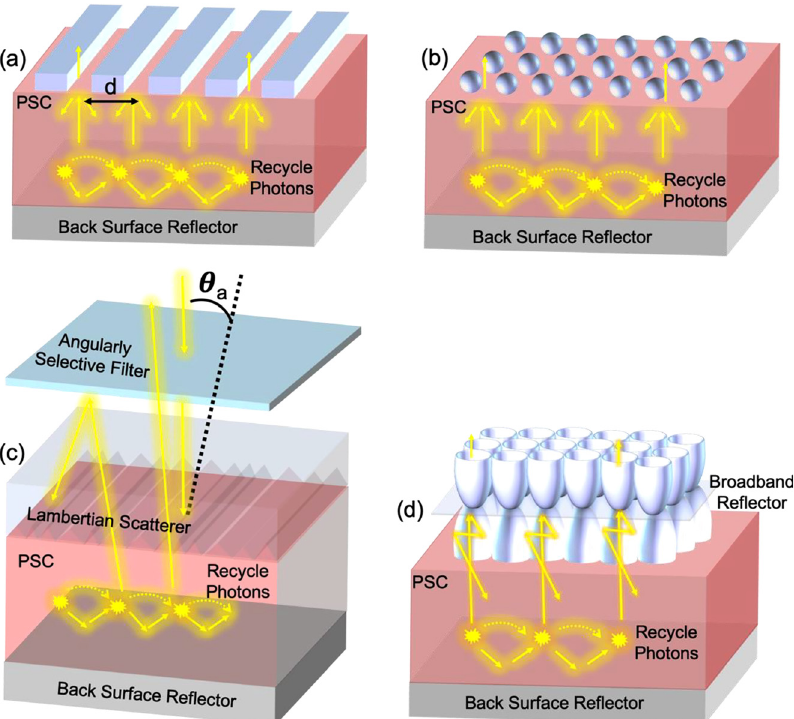
Figure 10: Schematic design of proposed light-trapping structure for photon recy- cling in